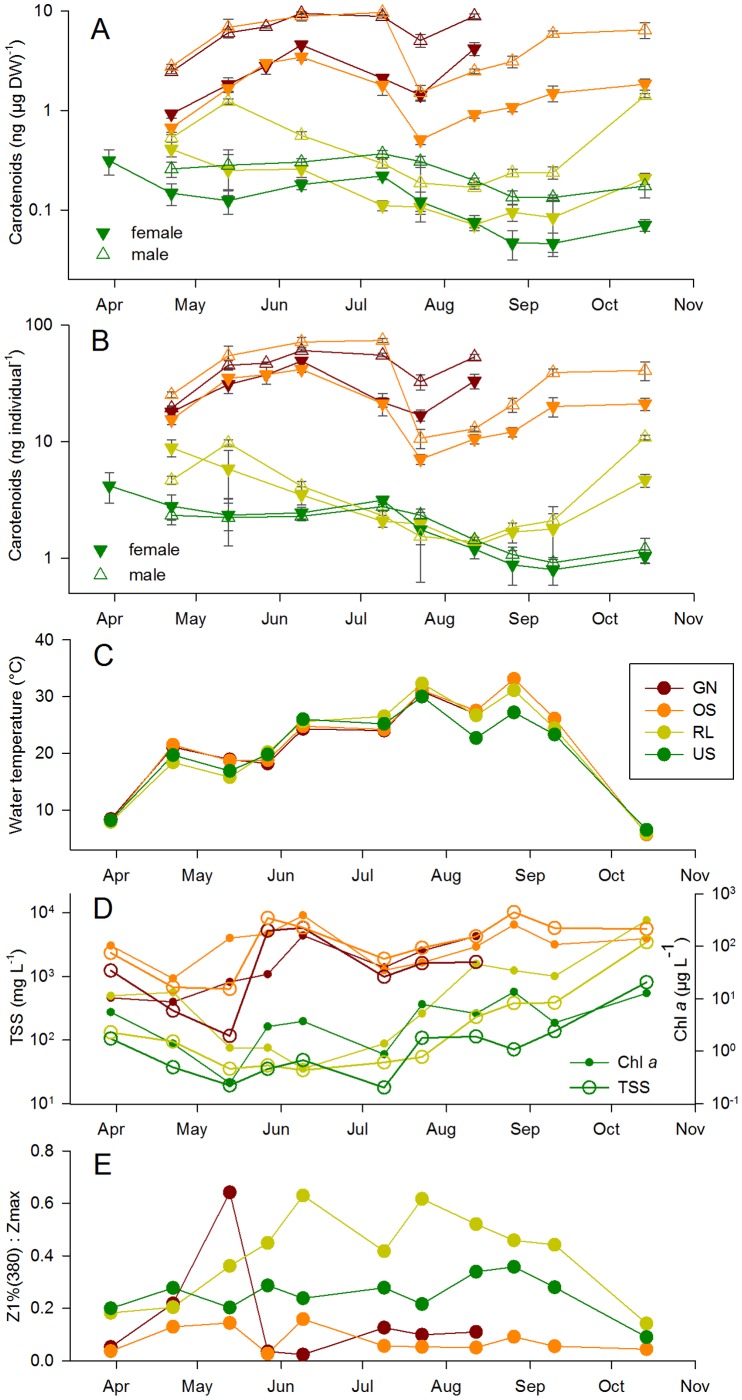
Seasonality of carotenoid concentrations in A. spinosus and environmental parameters.(A) carotenoid concentration normalized to dry weight, (B) carotenoids per individual copepod, (C) water temperature, (D) total suspended solids and chlorophyll a, and (E) Z1%(380) : Zmax as an estimate of UV exposure (inverse of depth refuge). The four studied lakes are indicated by different colors. Carotenoids, TSS and Chl a are displayed in log scale. In A and B, full downward triangles represent females’ values, open upward triangles males’ values. In D, the solid line and symbols represent TSS, the dotted line Chl a.